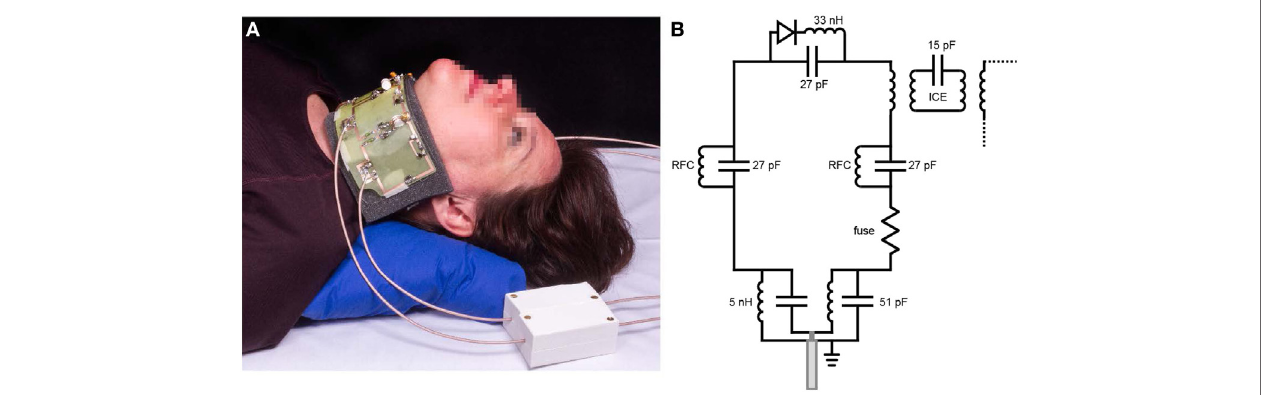
FIgURe 2 | (A) The dedicated larynx coil with the electronics visible (an encased version is used for in vivo scans). The coil is flexible and, therefore, adjustable to different neck sizes. The white boxes are floating cable traps, which prevent current from flowing on the outer shield of the connecting cables. Written informed consent was obtained from the subject for publication of this photo. (B) A schematic of the electrical circuit of each of the four loops constituting the coil. The individual loops are decoupled from the neighboring elements using an induced current elimination (ICE) circuit. Radiofrequency chokes (RFCs) are used to allow a DC current path to turn on the PIN diodes to isolate the receive coils from the transmit body